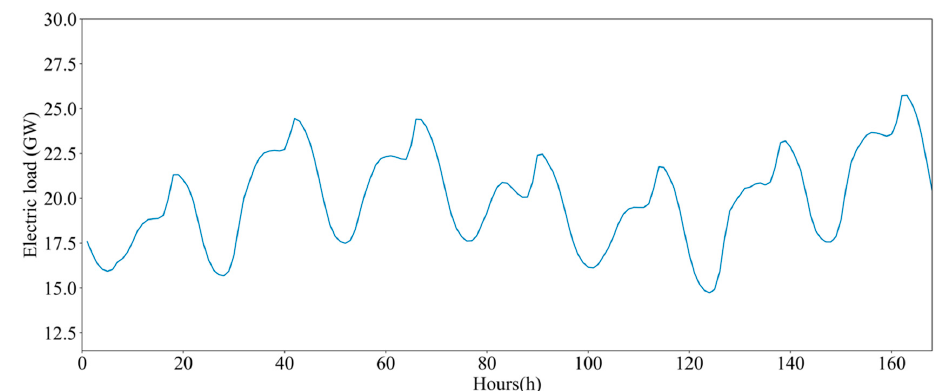
Figure 6. The graph of a year of load data.